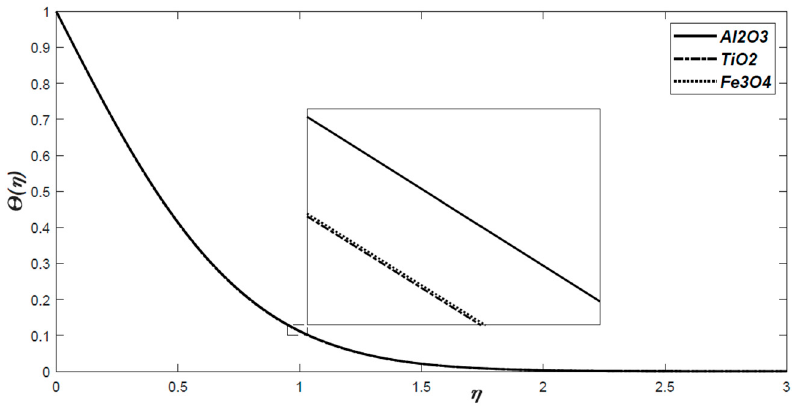
Figure 2. The dimensionless temperature profiles for φ = 0.02 for all three nanofluids with respect to similarity variable η .